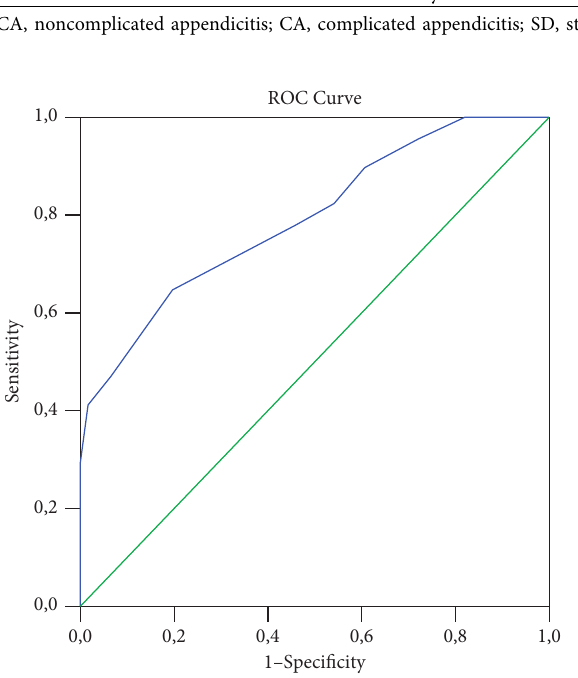
Figure 1: Receiver operating characteristic curve (ROC) analysis representing the curve obtained to differentiate patients with noncomplicated appendicitis from patients with complicated ap- pendicitis (AUC � 0.793, 95% CI: 0.719–0.868, p < 0 .